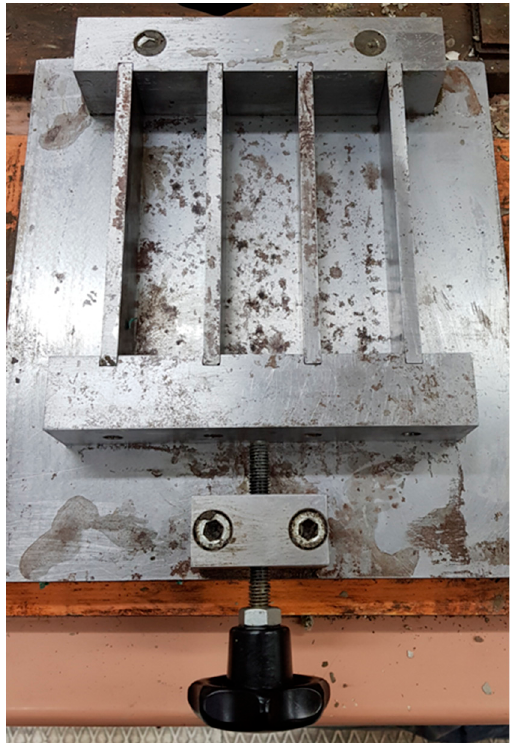
Figure 9. The molds for the beams.